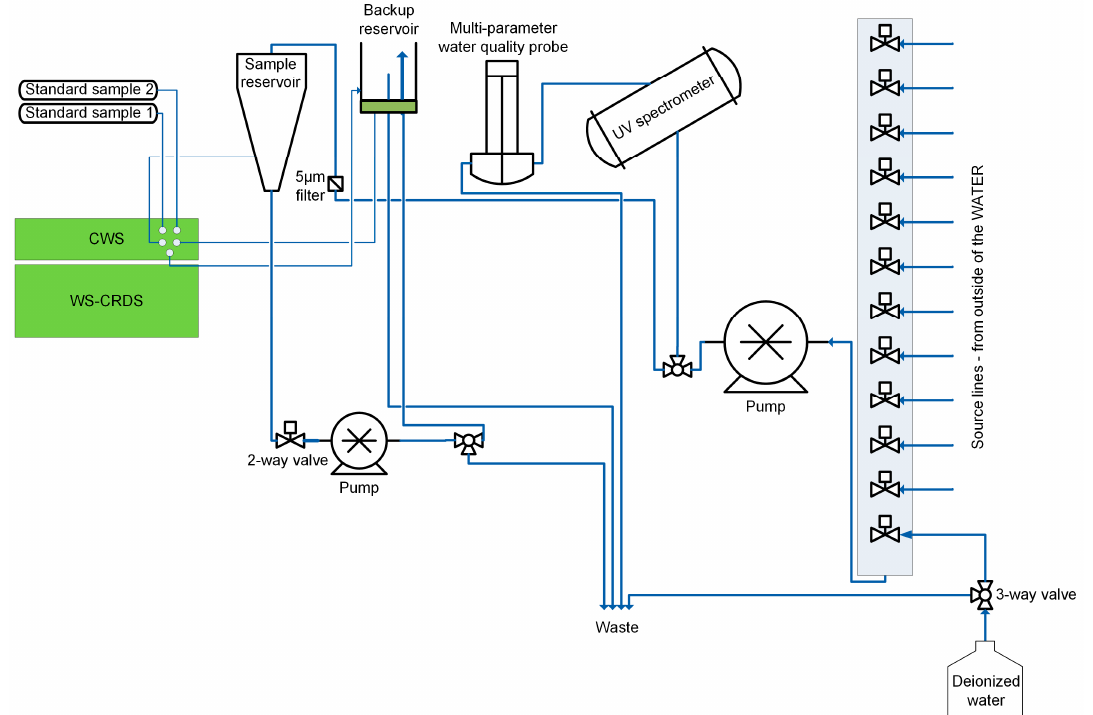
Figure 3. Schematic of the sampling board and analytical instrumentation inside the Water Analysis Trailer for Environmental Research (WATER). CWS = continuous water sampler, WS-CRDS = wavelength-scanned cavity ring-down spectrometer.